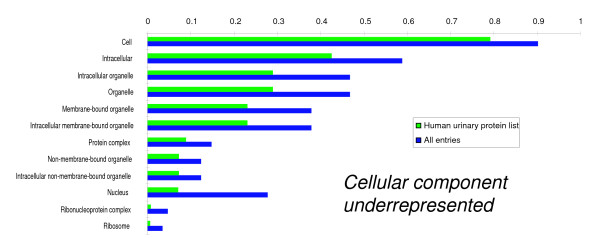
Significantly under-represented GO cellular component, molecular function and biological process terms for the set of identified urinary proteins. Each term was selected as described in the legend to Figure 6. GO, Gene Ontology.